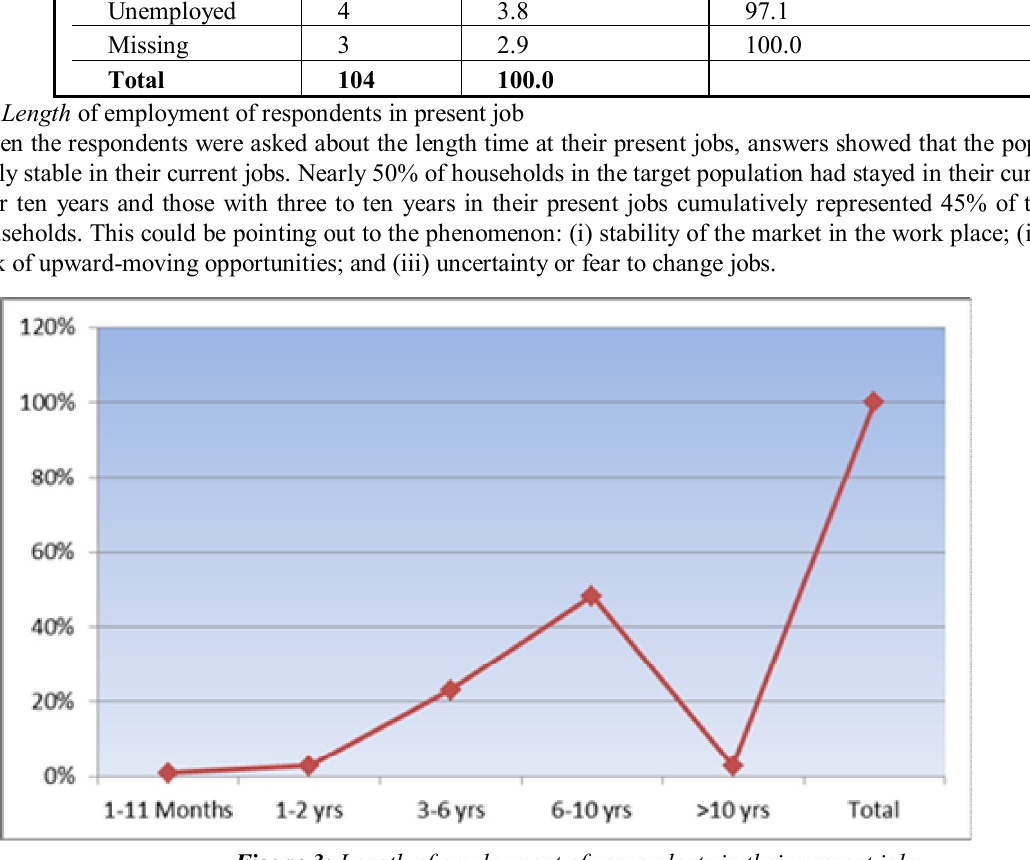
Figure 3: Length of employment of respondents in their present